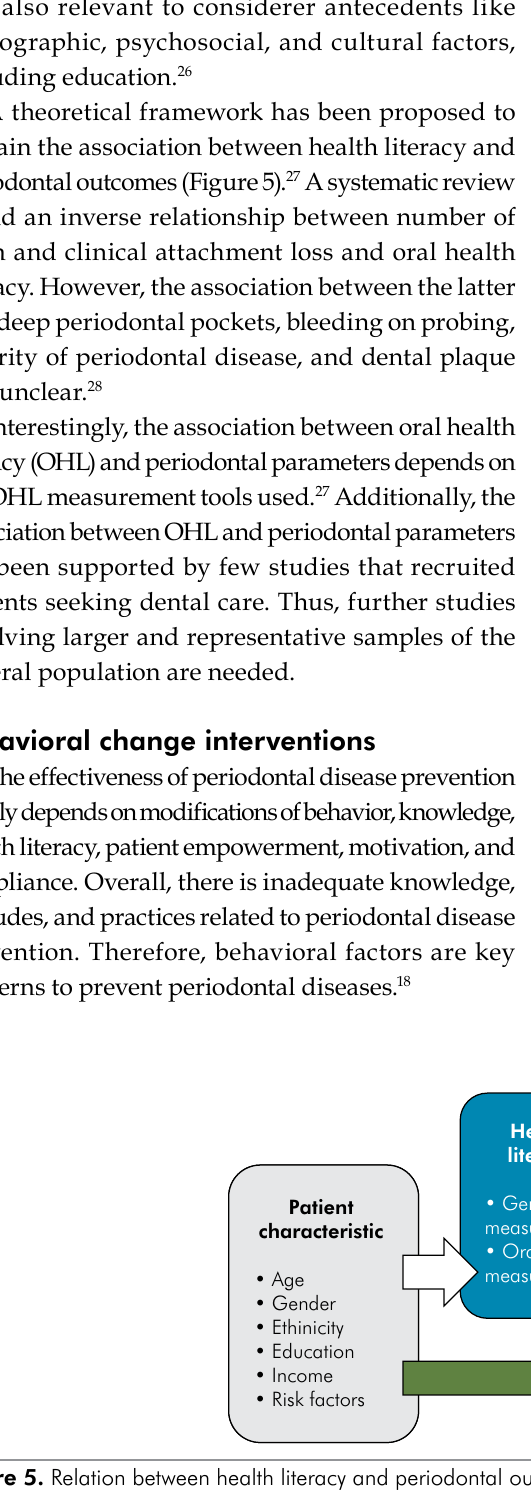
Figure 5. Relation between health literacy and periodontal outcomes. Adapted from Holtzman et al. 27